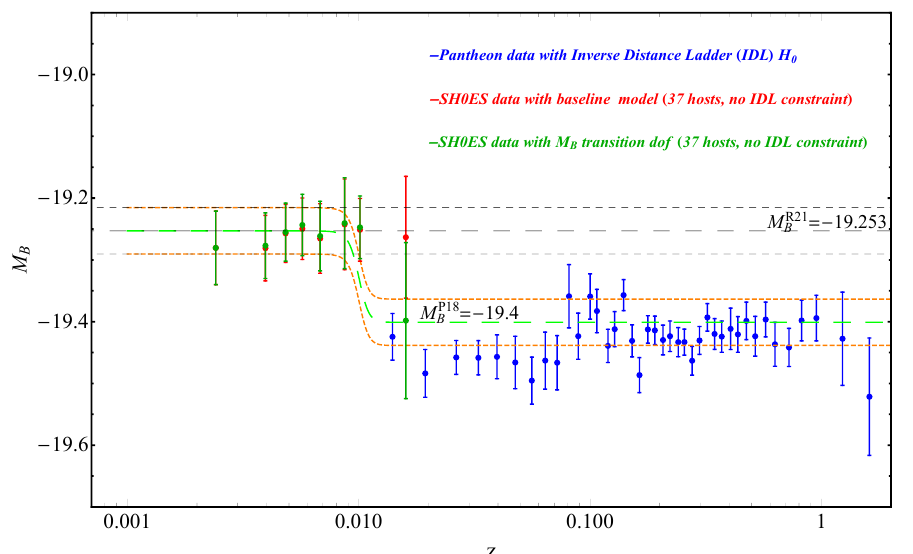
Figure 17. The binned (5 host bins with 2 hosts in last bin where z > 0.01) Cepheid+SnIa host values of M B obtained assuming the baseline SH0ES model (red points) and the M B transition model ( D c = 50 Mpc, green points) are shown along with the inverse distance ladder calibrated binned M B of the Hubble flow SnIa of the Pantheon dataset (blue points). When the transition dof is allowed, the data excite it, and a hint of a transition appears (the green data point of the transition model is clearly below the red point corresponding to the constant M B SH0ES baseline